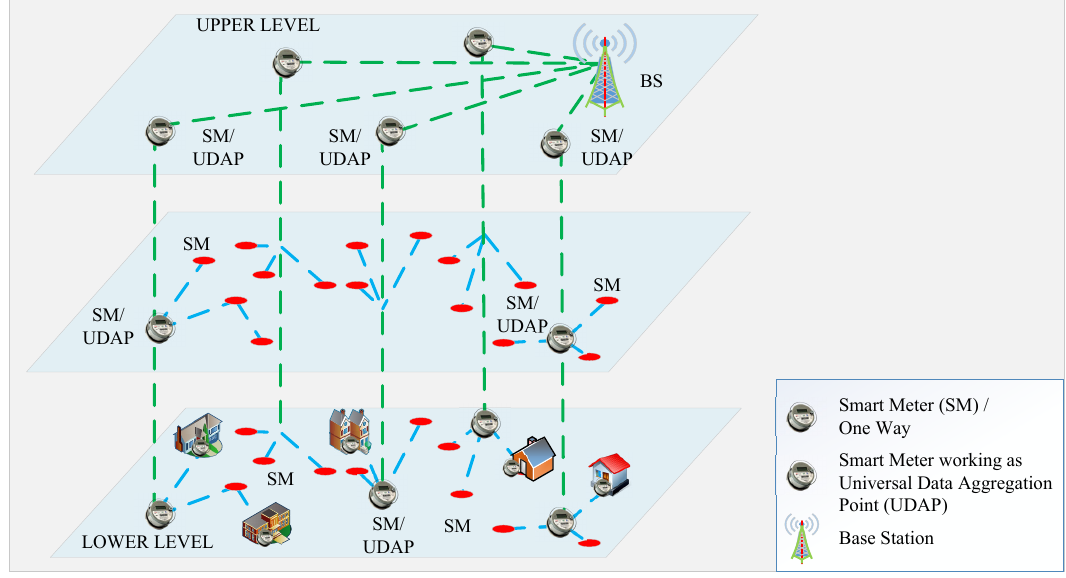
Figure 1. Multigraph representing an AMI wireless heterogeneous